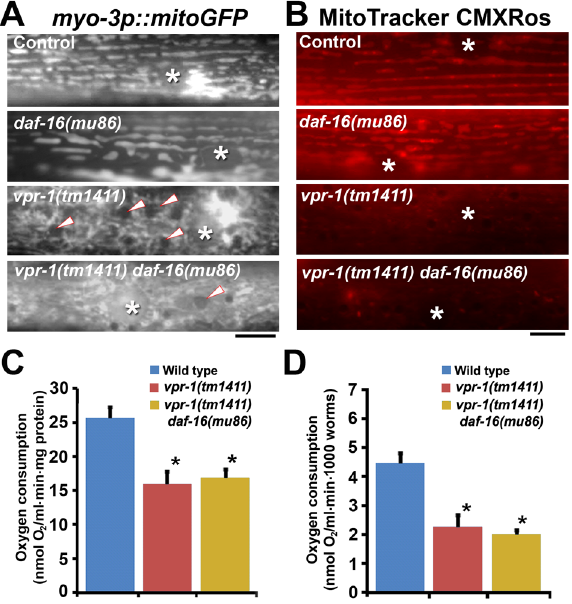
Figure 7. Effect of DAF-16 inactivation on muscle mitochon- dria. (A) Muscle mitochondrial tubules in indicated genotypes visualized using mitoGFP. Arrowheads indicate fat droplets. Asterisks indicate nucleus. Bar, 5 m m. (B) MitoTracker CMXRos staining of wild- type and mutant muscle. Asterisks indicate nucleus. Bar, 5 m m. (C and D) Oxygen consumption rates of wild-type and mutant hermaphrodites. Measured consumption rates were normalized by protein content (C) or number of worms (D). Error bars represent SD. *, P , 0.001 compared to wild type. Oxygen consumption rate of wild-type and vpr-1(tm1411) mutants includes published data [15] measured together with vpr-